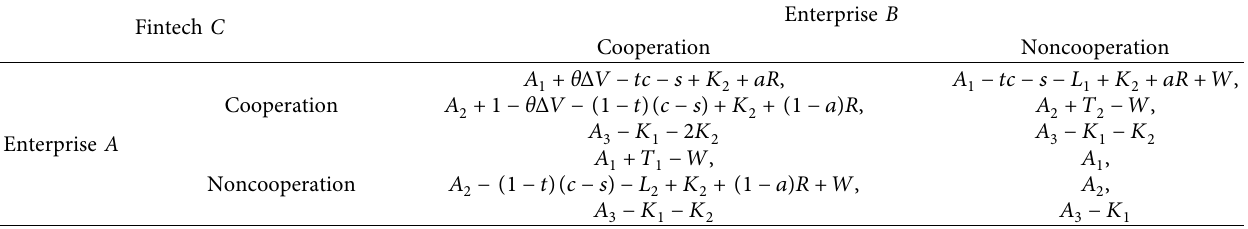
Table 3: Payment matrix of fintech institutions participating in the three-party game.